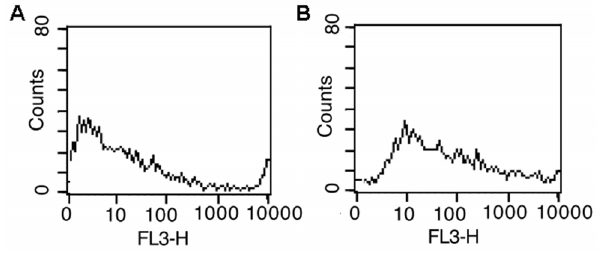
Figure 6. Flow cytometric analysis. (A) MCF-7 and (B)MDA-MB-231 cells after transfected with probe loaded complex.